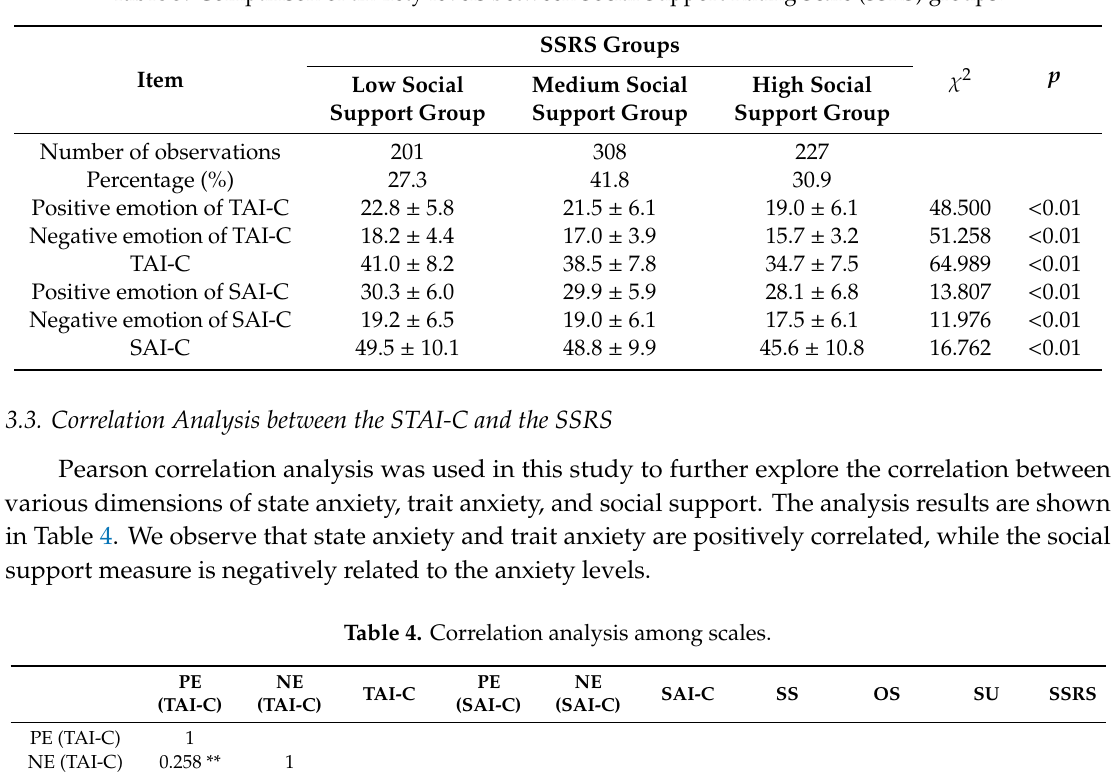
Table 3. Comparison of anxiety levels between Social Support Rating Scale (SSRS) groups.